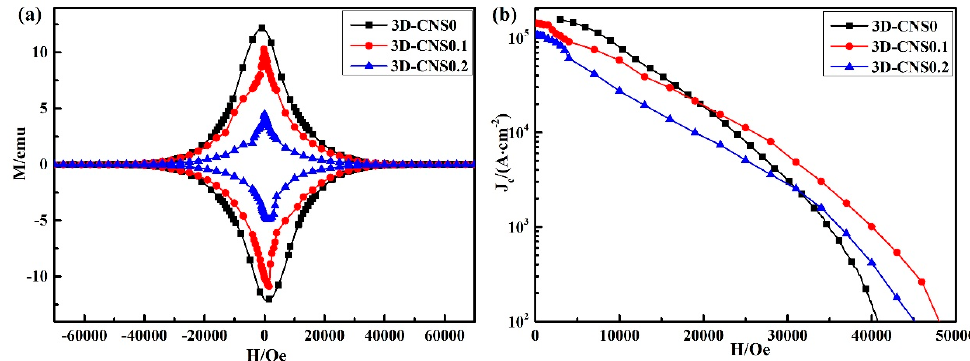
Figure 8. ( a ) Magnetic hysteresis loops ( b ) critical current density ( J c ) as a function of magnetic field at 20 K for undoped and 3D-CNS doped samples.